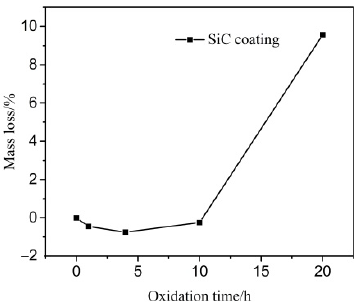
Figure 6. Oxidation curve of the SiC coating at 1773 K.